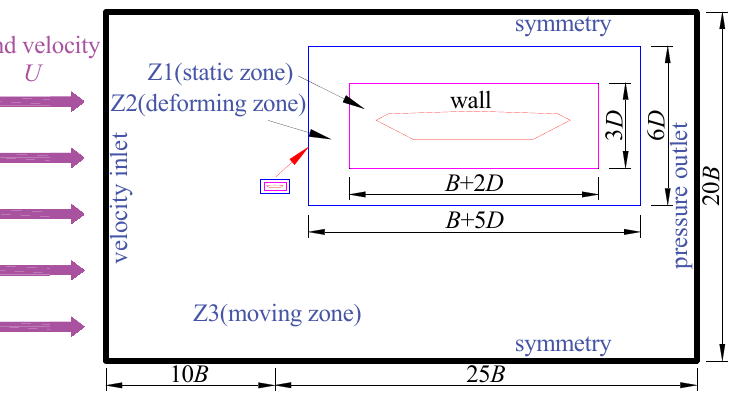
Figure 3. Computational domain, boundary conditions, and blocks.